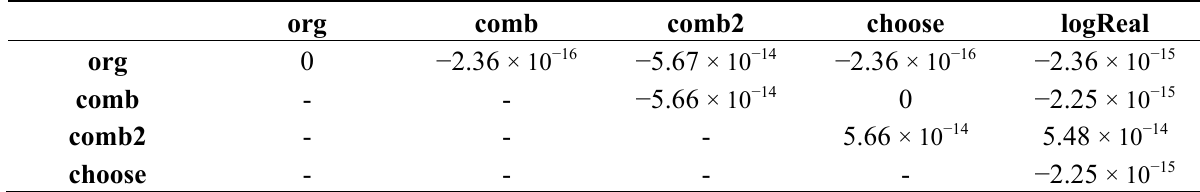
Table 3. Maximum differences between each of the methods used to calculate the P correction